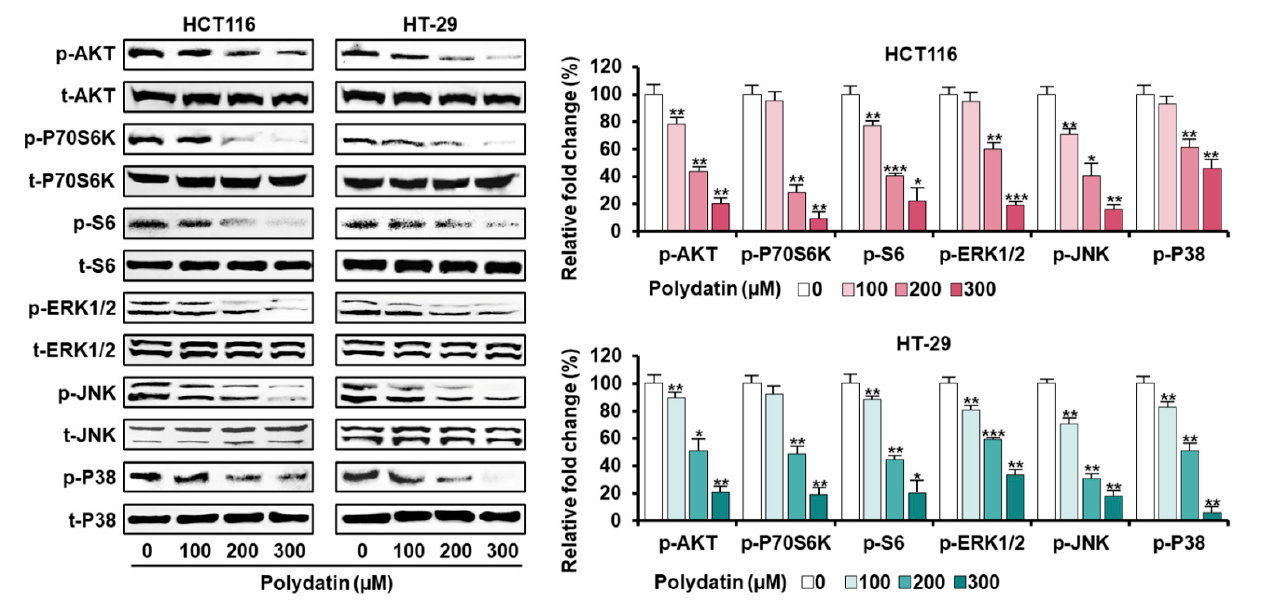
Figure 4. Dose-dependent inhibitory effects of polydatin on MAPK and PI3K/AKT signaling pathway in HCT116 and HT-29 cells. Each protein’s phosphorylation level was quantified with each total protein. The asterisks signify statistical variation among polydatin-treated and vehicle-treated groups (* p < 0.05, ** p < 0.01, and *** p < 0.001).